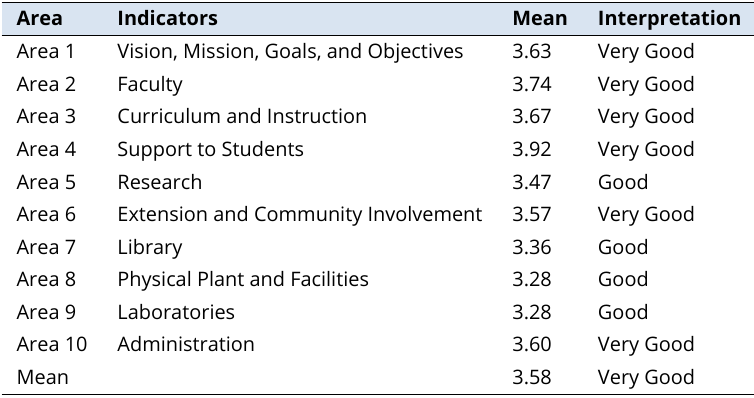
Summary of Survey